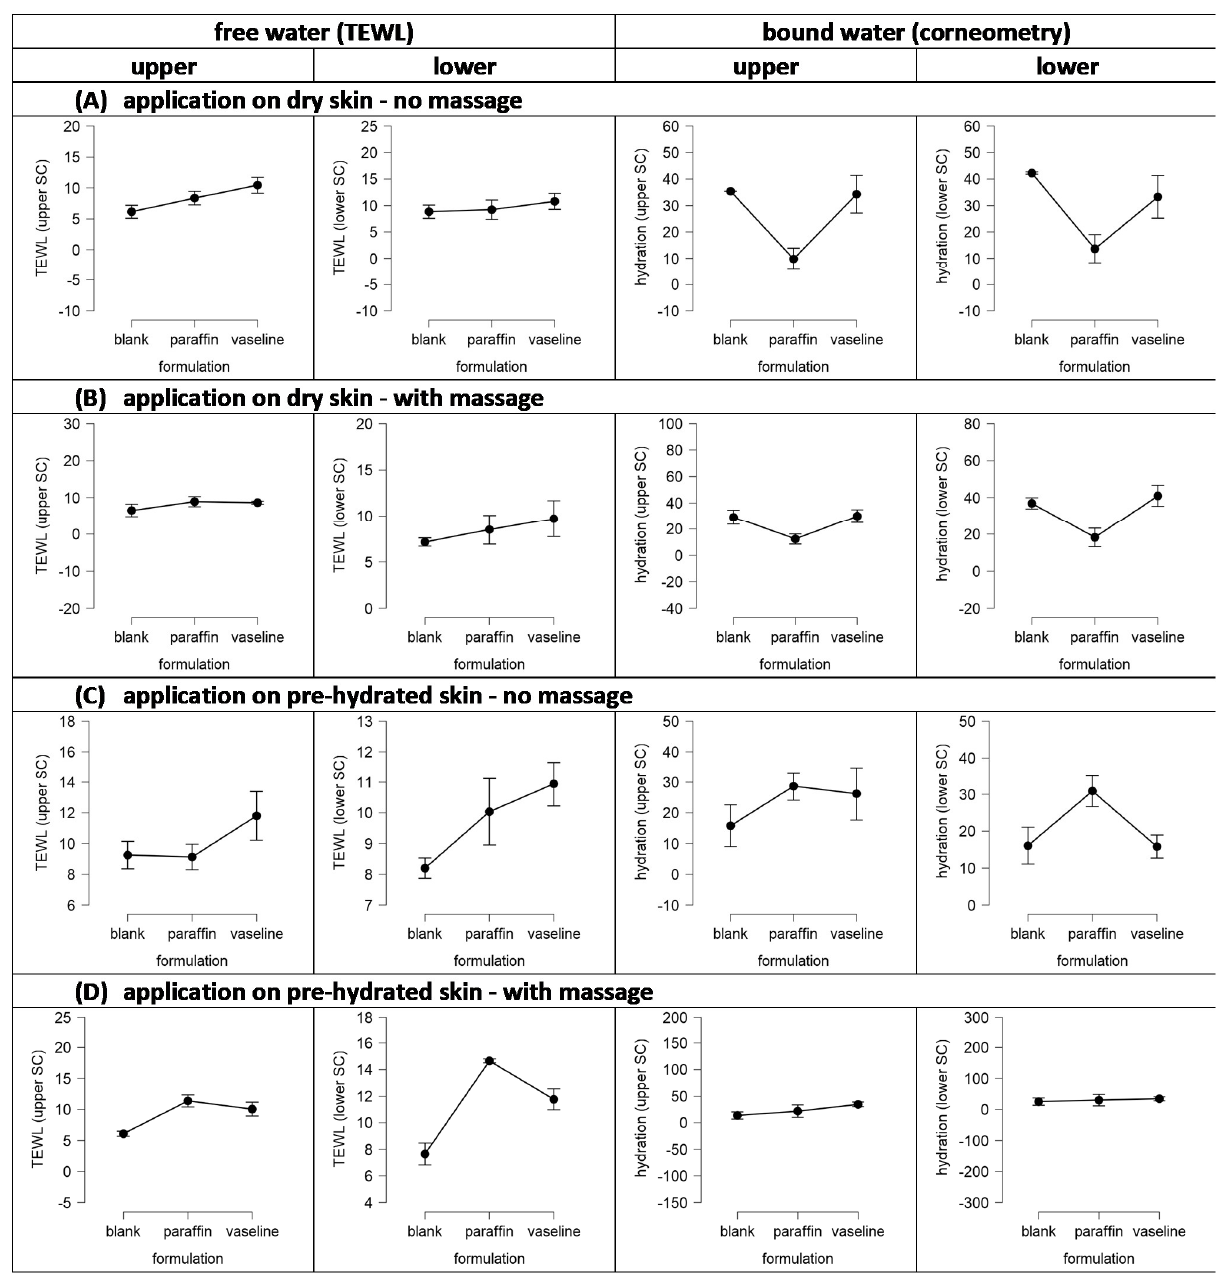
Figure 8. Influence of formulation, application, and skin condition on skin hydration. TEWL measurements were performed to assess the amount of free and unbound water. Corneometer measurements were performed to measure the capacitance of the skin tissue to assess the amount of water bound in the tissue. Measurements were taken from the skin surface ( upper ) and after tape stripping ( lower ) to assess the water content in the deeper layers of the stratum corneum (detailed explanations—cf. text).